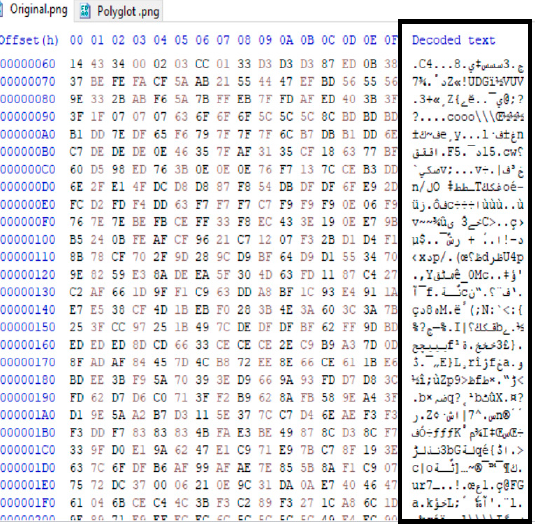
Figure 10. Exploit triggered in Firefox browser.